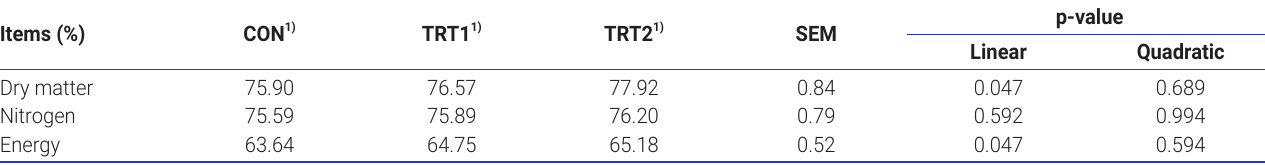
Table 3. Effect of dietary supplementation Achyranthes japonica extracts on nutrient digestibility in growing pigs Items (%)